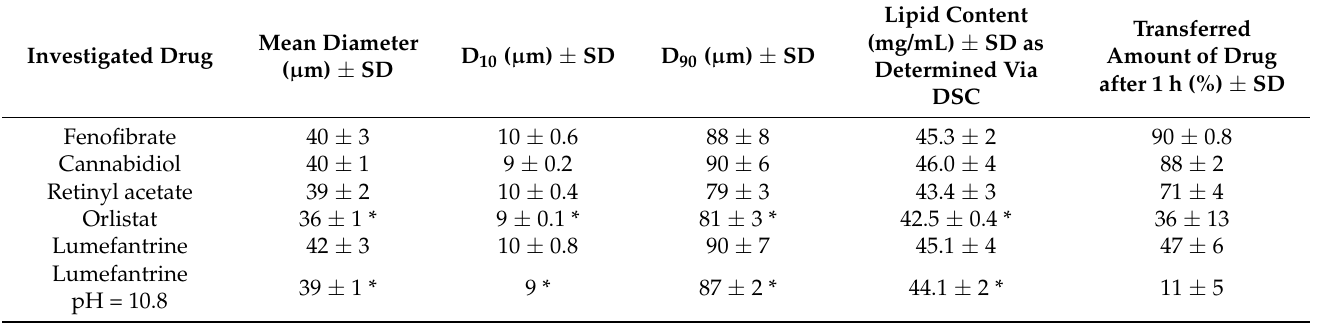
Table 2. Size and lipid content of the different batches of lipid-containing hydrogel microbeads and transfer results obtained applying the respective hydrogel beads. All values n = 3 batches ± standard deviation or n = 2 batches (marked with *).